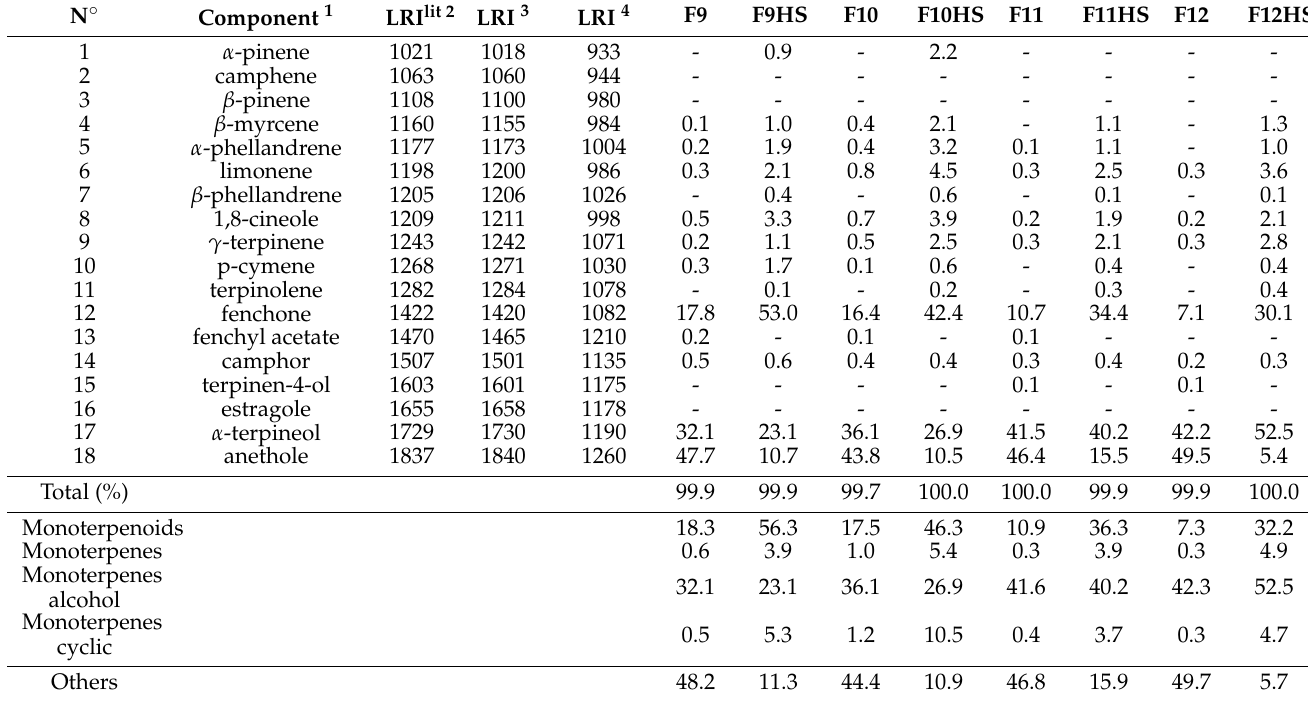
Table 4. Chemical composition (%) of FVEOs from Kotor analyzed by GC/MS and